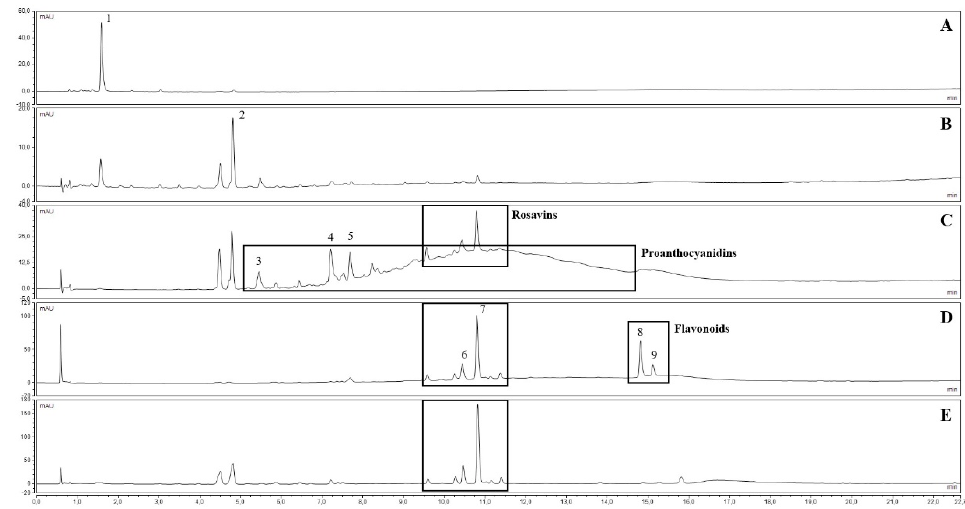
Figure 1. UV chromatograms at 270 nm of “Mattmark” fractions ( A ): Fraction 1 (M F1 0%); ( B ): Fraction 2 (M F2 20%); ( C ): Fraction 3 (M F3 40%); ( D ): Fraction 4 (M F4 70%); ( E ): Fraction 5 (M F5 PVP)). Compounds: 1 = gallic acid, 2 = salidroside, 3 = EGC-EGCG dimer, 4 = EGCG-EGCG dimer, 5 = EGCG, 6 = rosarin, 7 = rosavin, 8 = rhodiosin, 9 = rhodionin; for details see Table S1.